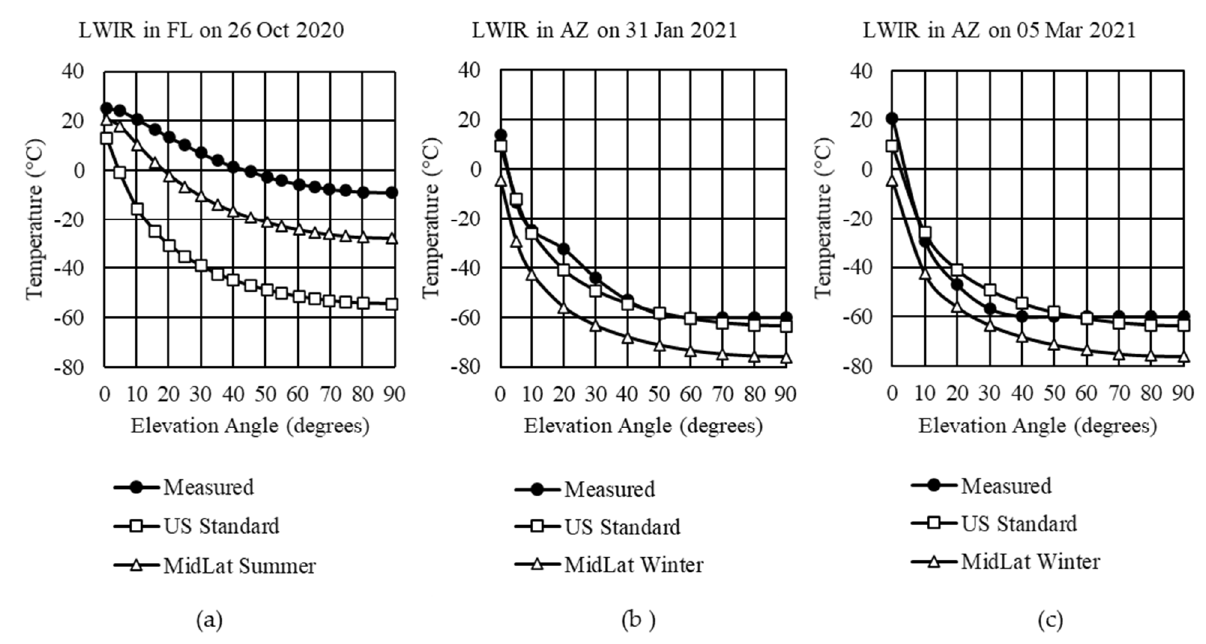
Figure 4. LWIR measured sky temperatures compared with MODTRAN’s standard profiles: ( a ) Example 1 in Cape Canaveral, Florida; ( b ) Example 2 in Tucson, Arizona; ( c ) Example 3 in Tucson, Arizona.